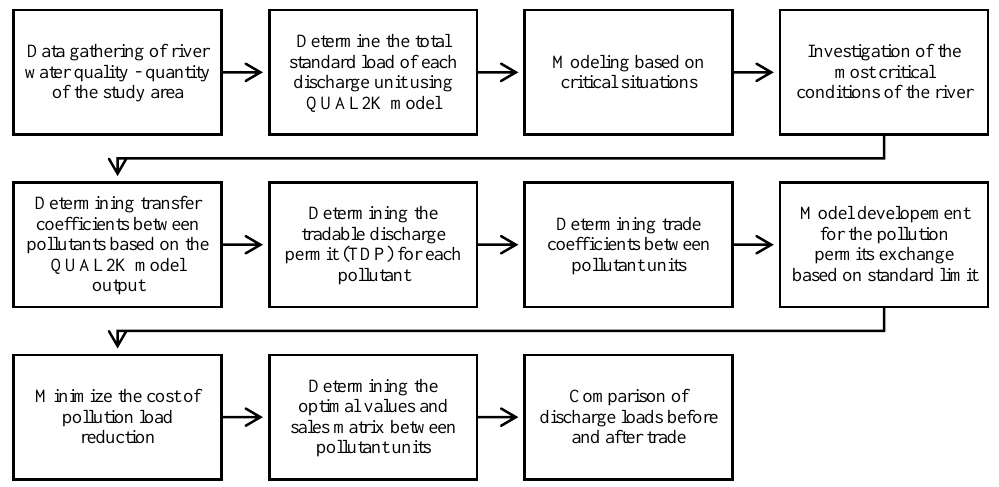
Figure 1. The flowchart of the developed method.